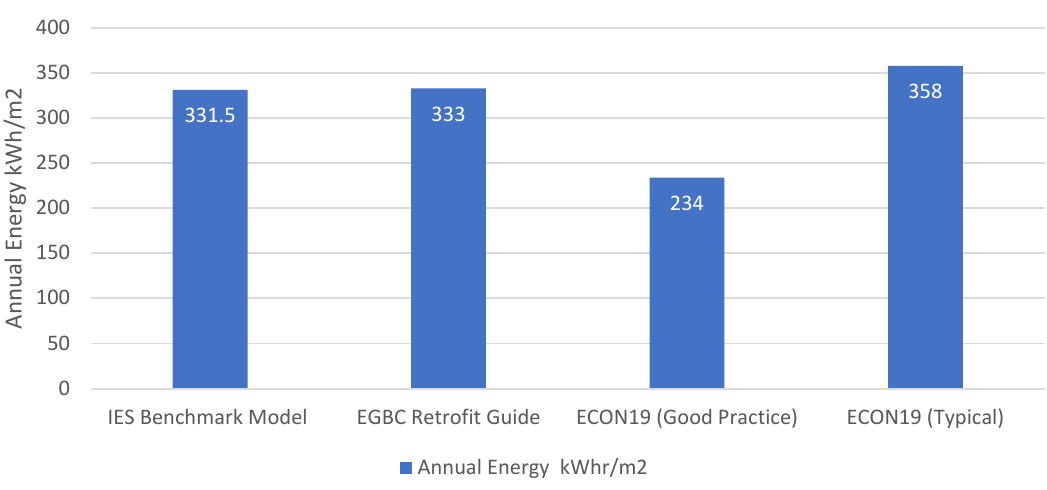
Figure 2. Annual energy intensity unit comparison.